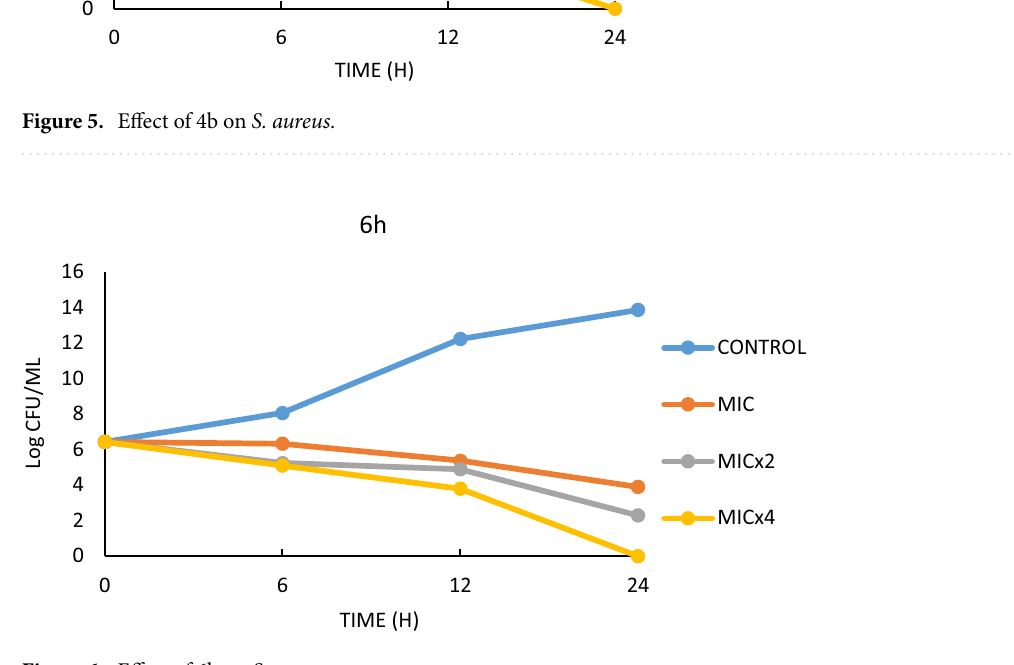
Figure 6. Effect of 6h on S. aureus